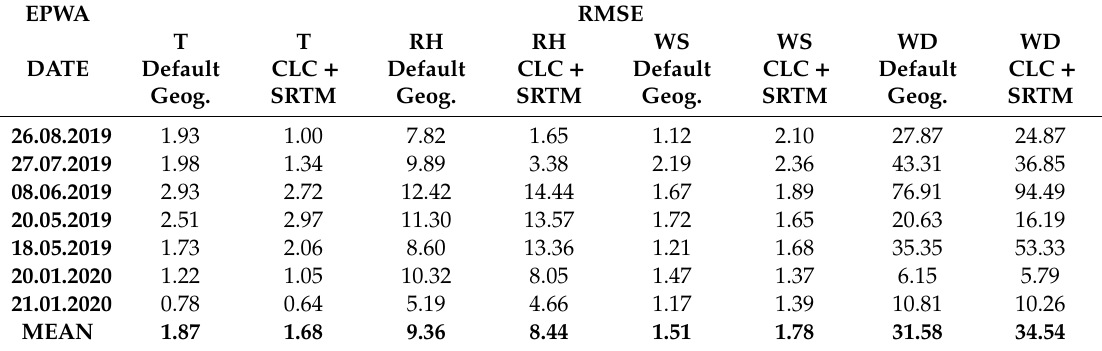
Table 7. RMSE for temperature (T), relative humidity (RH), wind speed (WS), and wind direction (WD) for the analyzed synoptic situations at EPWA, the period from 10:00 UTC to 15:00 UTC. EPWA RMSE